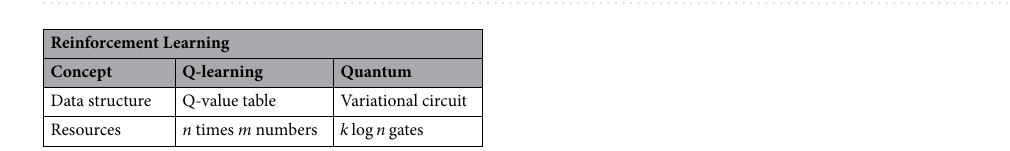
Table 1. Conceptual comparison of classical versus quantum